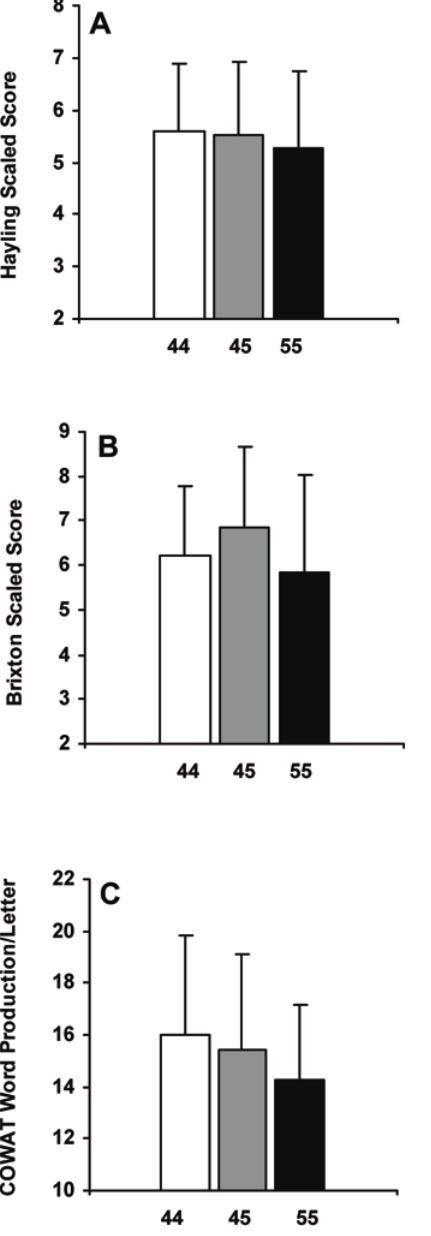
Figure 2. Executive function task performance after five nights of partial sleep deprivation for the PER3 groups. Mean ( 6 SD) (A) Hayling scaled scores, (B) Brixton scaled scores and (C) Controlled Oral Word Association Test (COWAT) word production per letter at SR5 for PER3 4/4 (A: n=47; B: n=48; C: n=46), PER3 4/5 (A: n=50; B: n=52; C: n=47) and PER3 5/5 (n=11) subjects. Higher scores indicate better performance on all tasks. None of these executive function tests showed significant differences across the PER3 genotypes (ps .